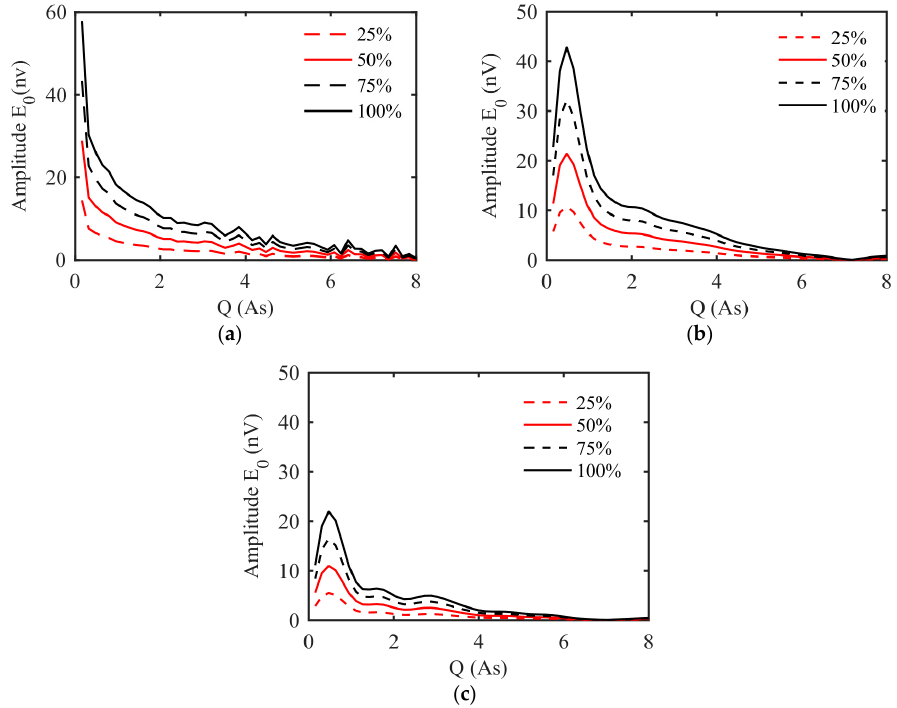
Figure 3. The underground MRS response E 0 − q curves from the forward model assuming a 1-m diameter coil, 40 turns for Tx and 128 turns for Rx. ( a ) a 2-m-thick water-bearing structure located 5 m ahead of the tunnel face with varying water content of 25%, 50%, 75%, and 100%; ( b ) a 2-m-thick water-bearing structure located 10 m ahead of the tunnel face with varying water content of 25%, 50%, 75%, and 100%; ( c ) a 1-m-thick water-bearing structure located 10 m ahead of the tunnel face with varying water content of 25%, 50%, 75%, and 100%.